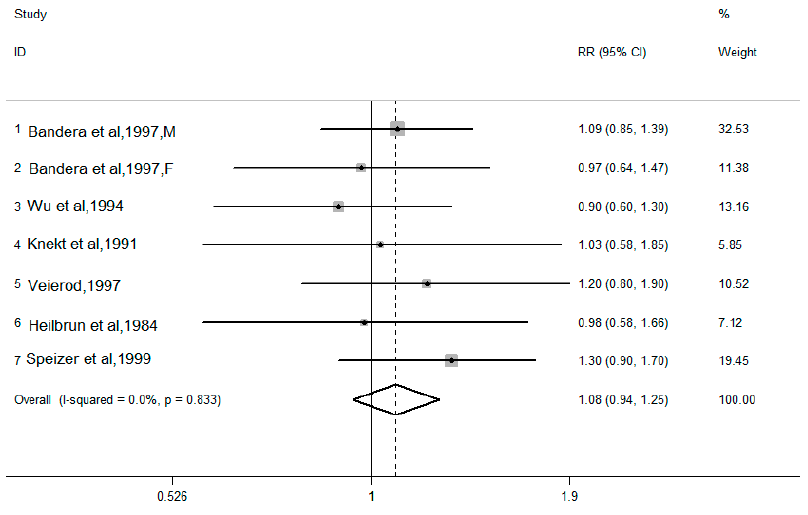
Figure 3. Forest plot of the highest compared with the lowest categories of intake of dietary cholesterol and lung cancer risk in six cohort studies.